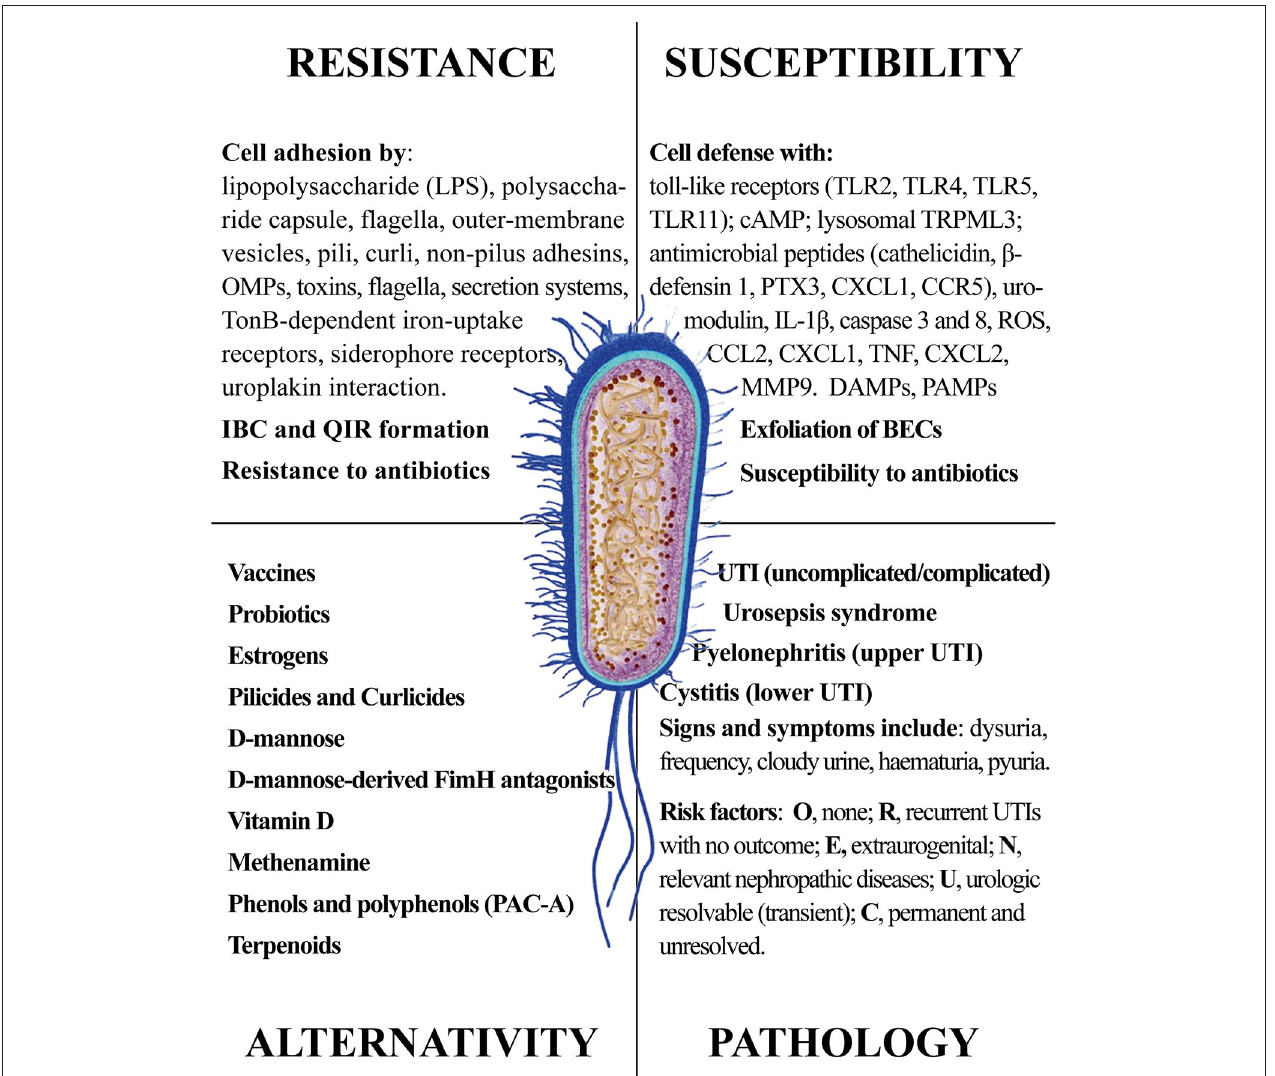
FIGURE 12 | The four main areas representing the Strengths and the Weaknesses of UPEC, the Opportunities for alternative remedies to antibiotics and, finally, the Treats that UPEC cause to human health. adherence. However, further studies are necessary to dissect the role of PAC-A in UTIs